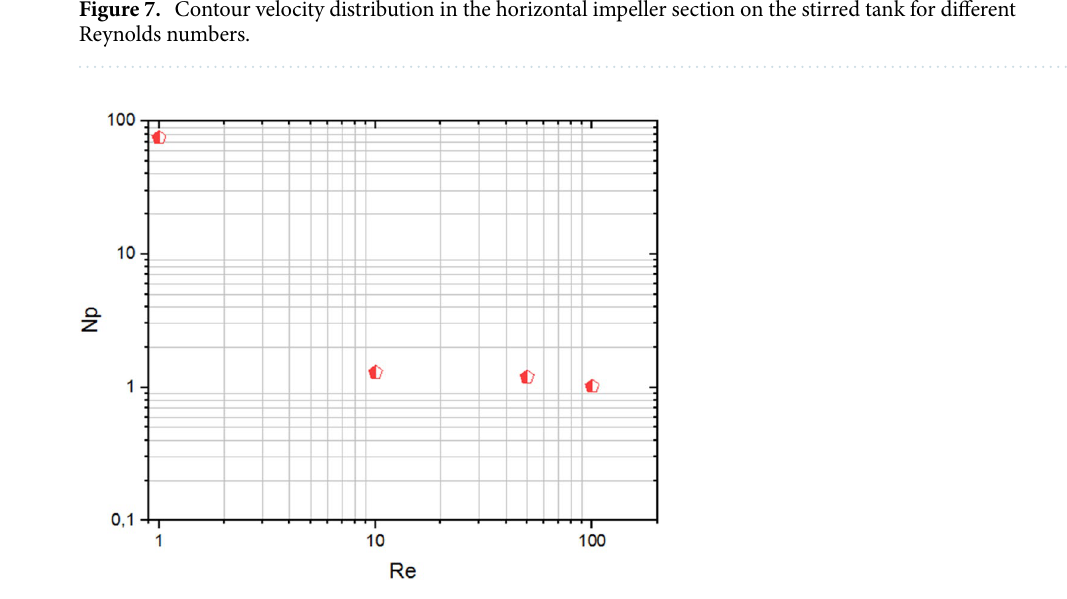
Figure 8. Power consumption versus different Reynolds